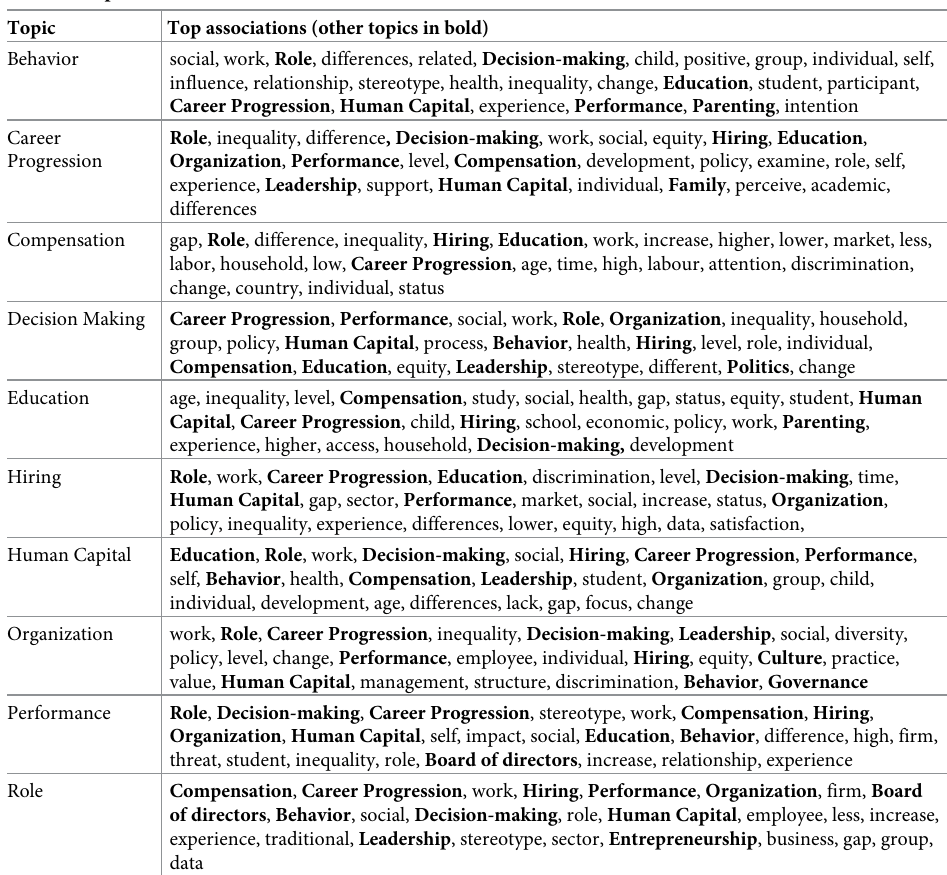
Table 3. Top associations.